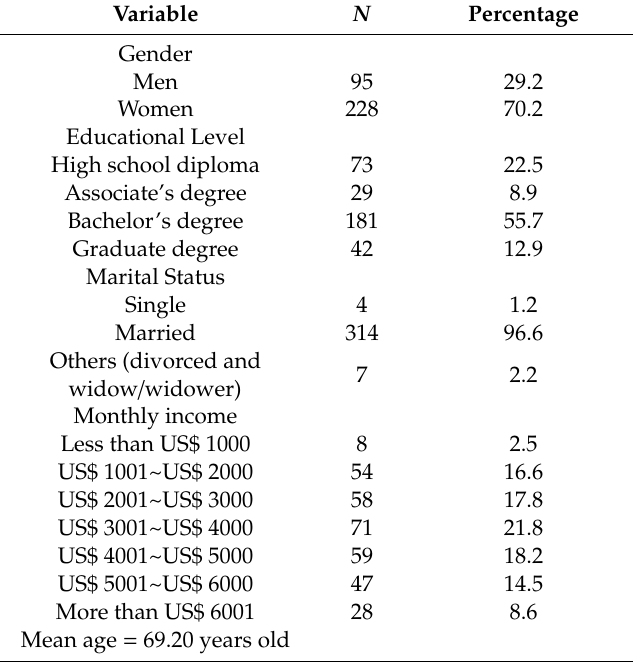
Table 1. Profile of survey respondents ( n =